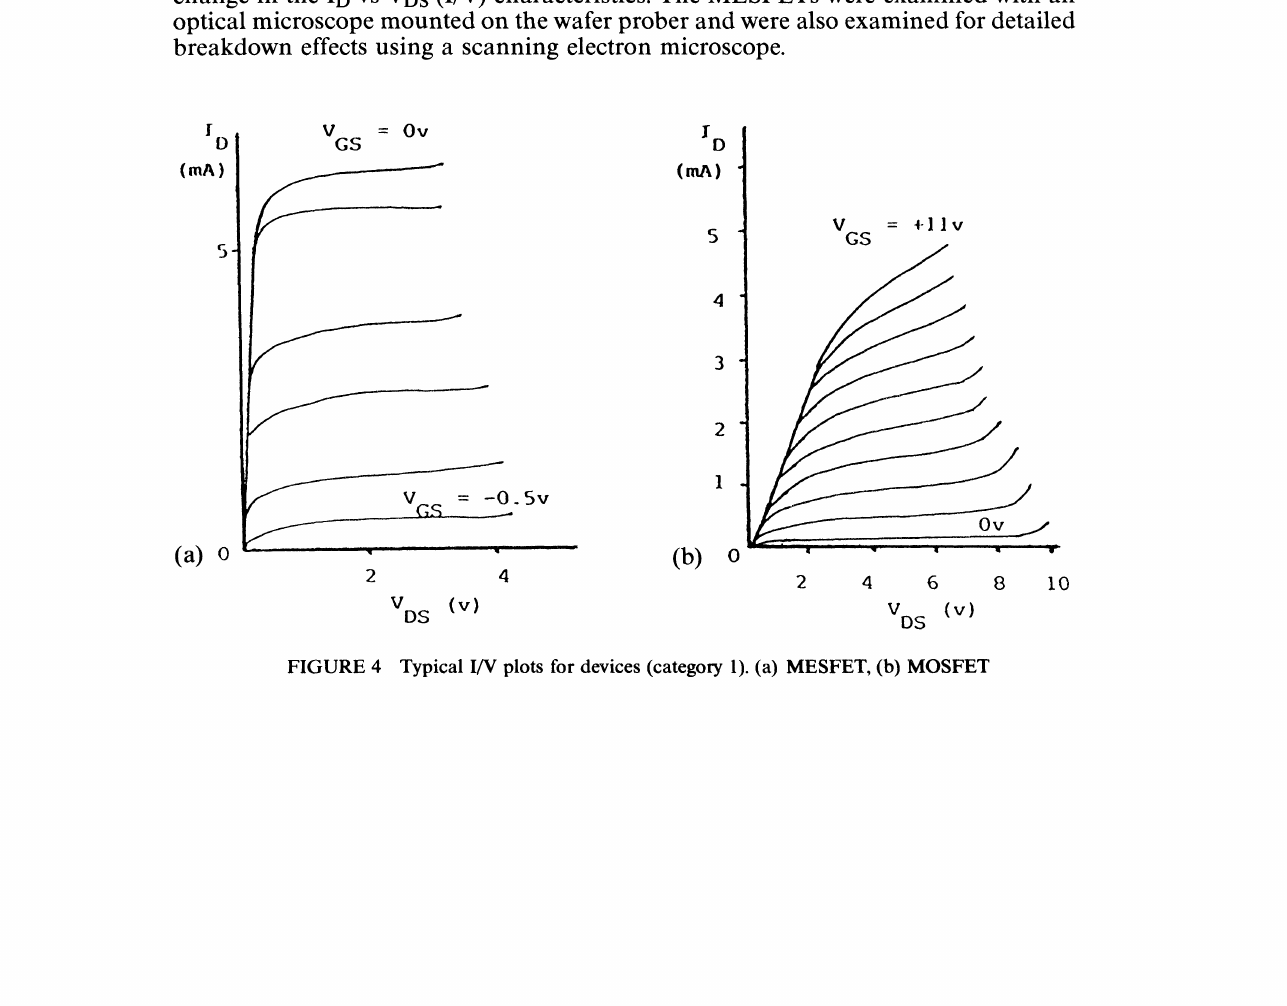
FIGURE 3 GaAs MESFET Surface